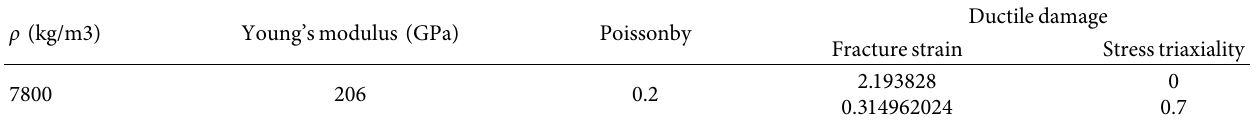
Table 5: Steel parameters.